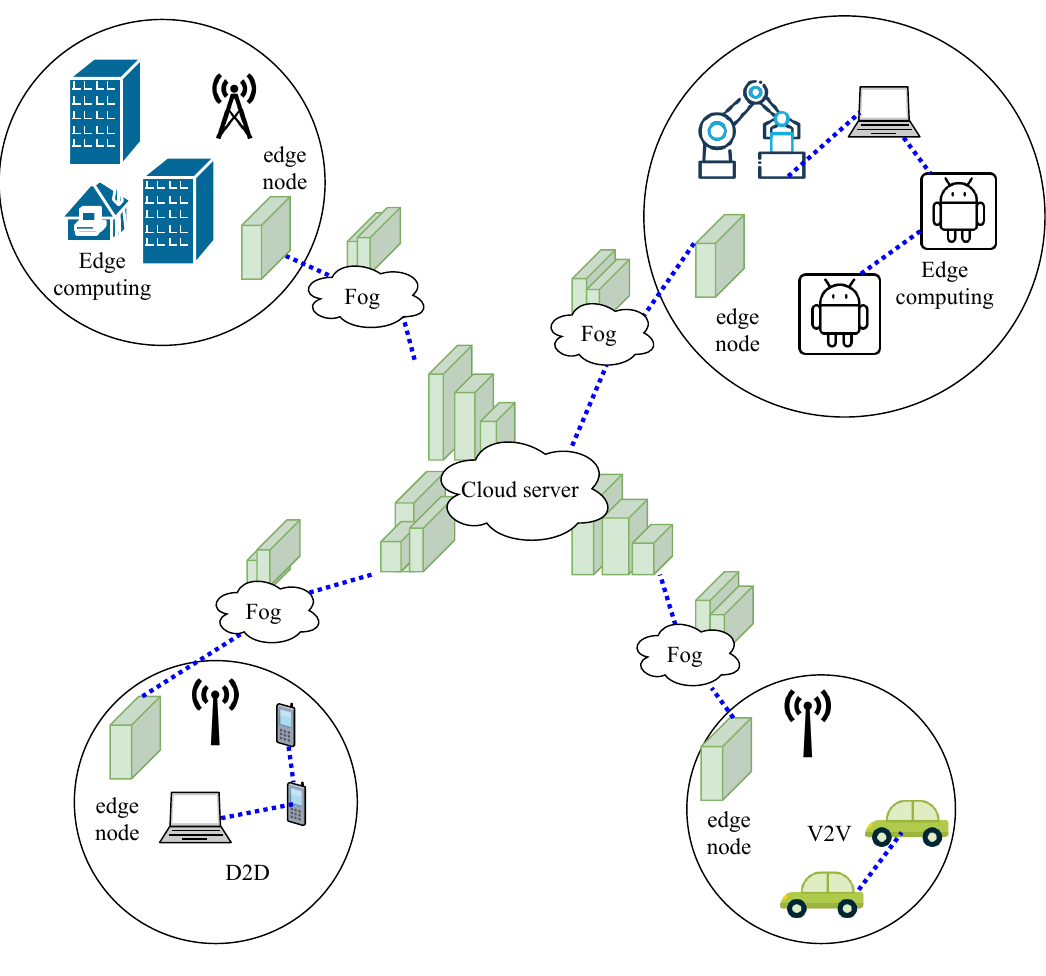
Figure 9. Overall view of three types of computing techniques namely, cloud, fog and edge and their connections and applications in a wireless